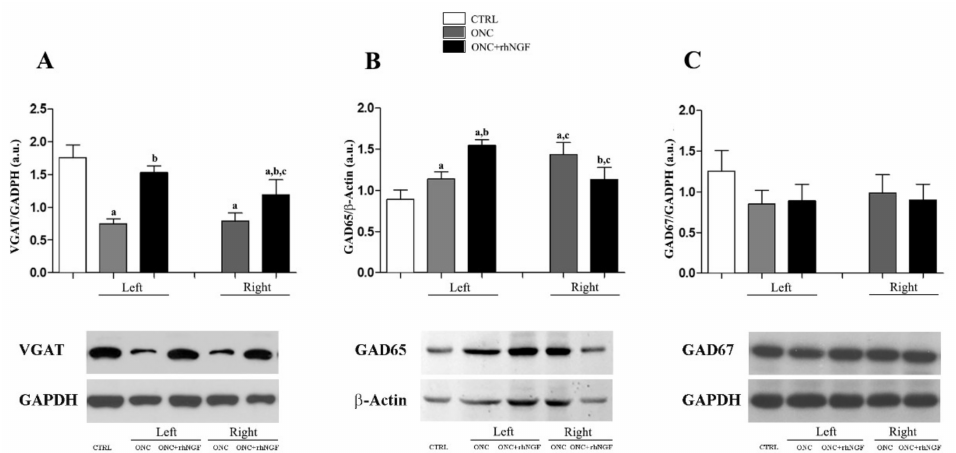
Figure 3. Expression levels of GABA markers in rat VCx. The semi quantitative evaluation of levels of VGAT, GAD65, and GAD67 in VCx of CTRL and left/right VCx of ONC and ONC+rhNGF rats are reported in the graphs ( A – C ). Representative cropped gels showing bands corresponding at the three proteins and loading control (GAPDH and β -Actin). Data are expressed as mean optical density (arbitrary units, a.u.) and presented as mean ± S.D. Statistically different: a vs. CTRL; b vs. ONC; c left vs. right VCx (same treatment condition).